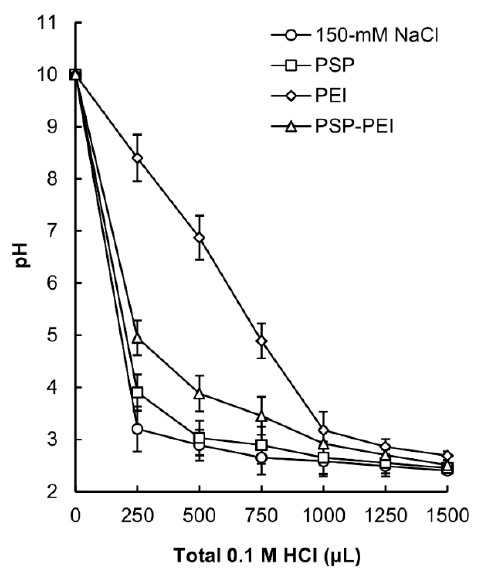
Figure 3. Acid-base titration profiles of PEI 25 kDa, PSP and PSP-PEI in a 150 mM NaCl solution.